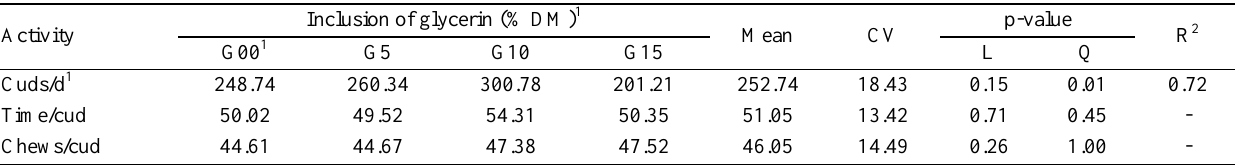
Chews/cud DM, dry matter; CV, coefficient of variation; Cuds/d, number of cuds per day; Time/cud, time spent per ruminated cud, in seconds; Chews/cud, number of chews per cud.